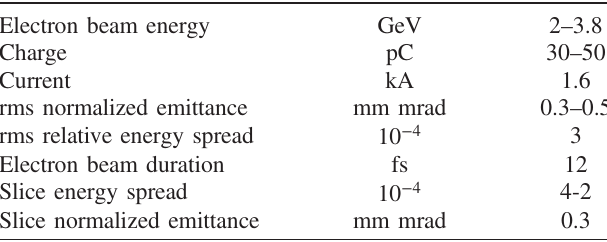
TABLE I. Electron beam for MariX